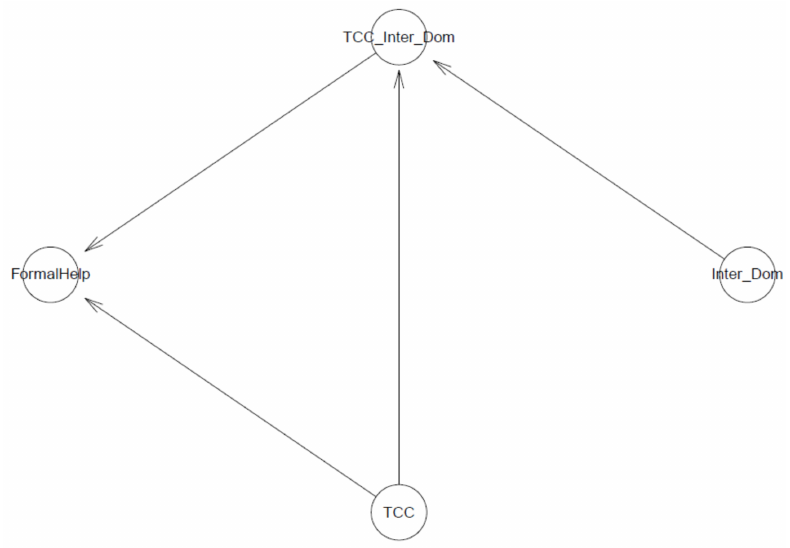
Figure 11. Model 3 (cid:48) s logical